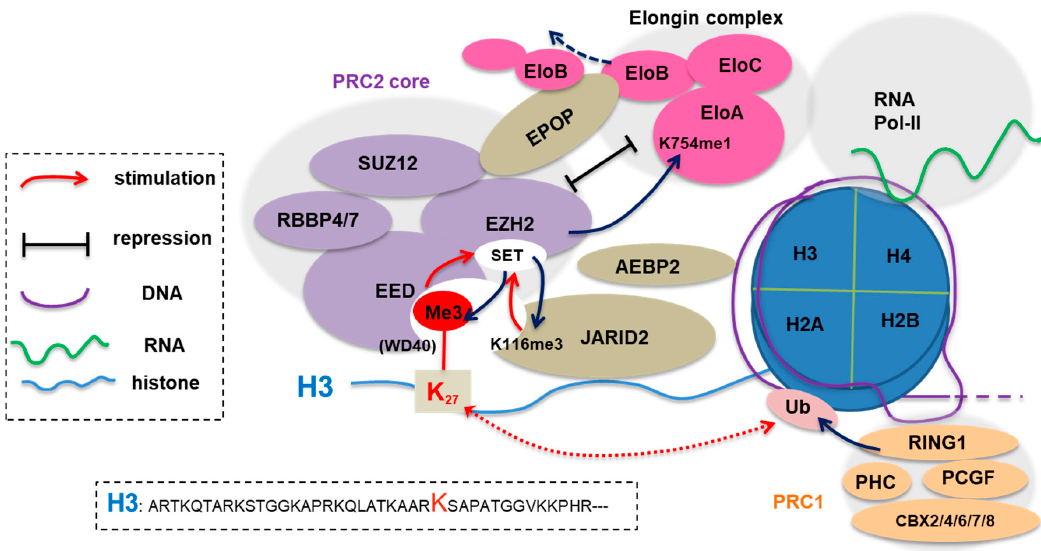
Figure 1. Enhancer of zeste homolog 2’s (EZH2) canonical function as enzymatic subunit of